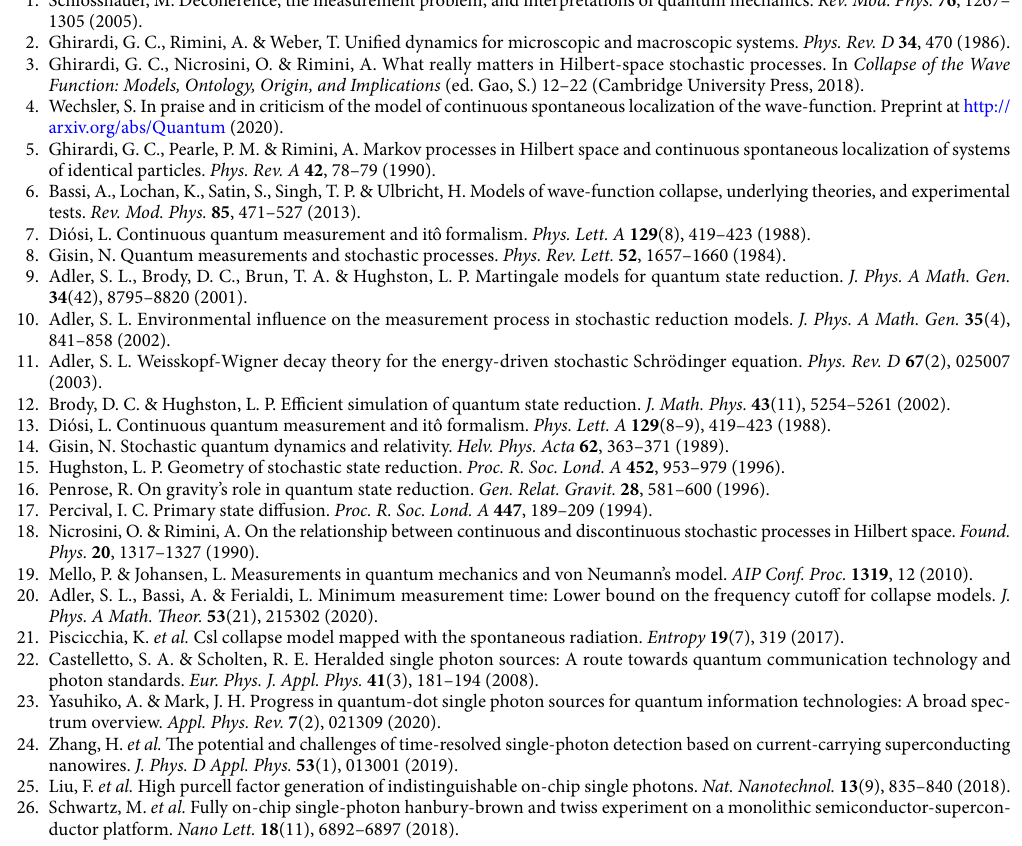
Figure 9. Persistence of the superposition. Fraction of paths with 𝜀 ≤ the paths converging to and 1/20, respectively, without von Neumann activation. The black and red curves represent the same situation with von Neumann activation. The setup with 𝛾 = 𝛾 1 and a single detector has been